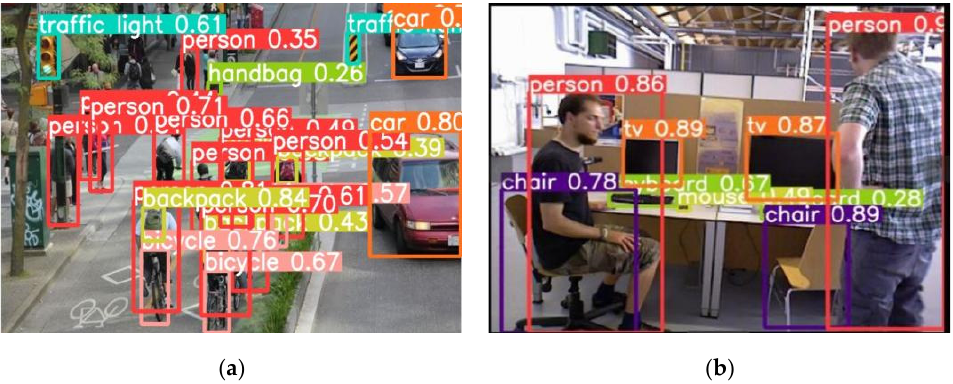
Figure 4. ( a ) YOLOv5 outdoor target recognition results; ( b ) YOLOv5 indoor target recognition results.